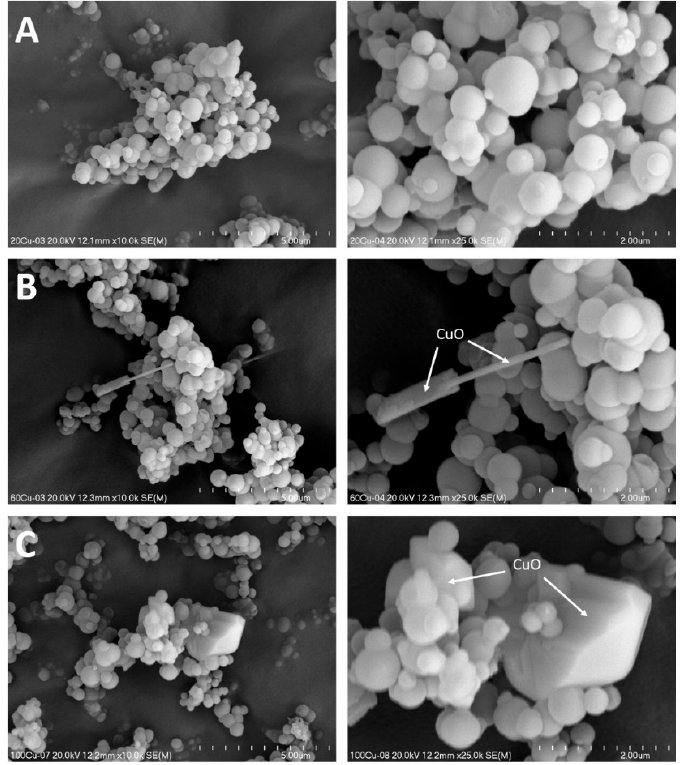
Figure 5. SEM images of the 20Cu ( A ), 60Cu ( B ) and 100Cu ( C ) samples at various magnifications.